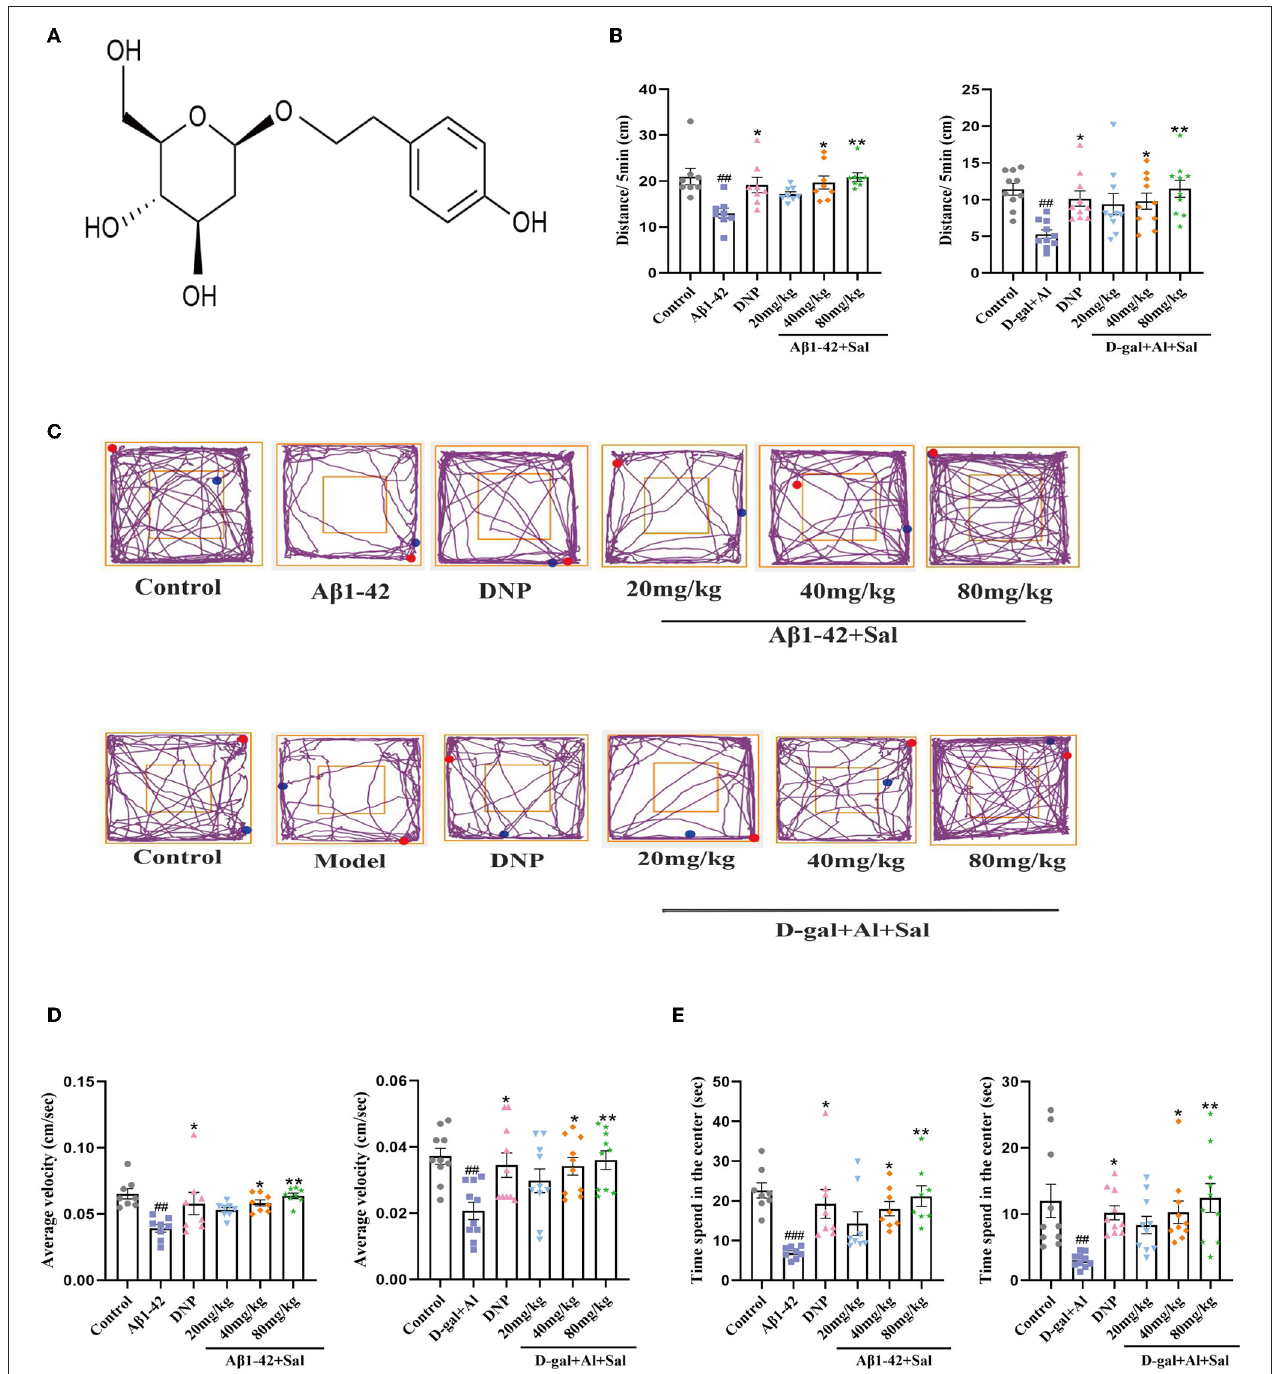
FIGURE 2 | Sal improves the autonomous exploration activities of A β 1-42 and D-gal/AlCl 3 -induced AD mice. (A) The chemical structure diagram of Sal. (B,D,E) Mice autonomic capacity test, using open field test. (B) Sal or DNP treatment decreased the total distance, (D) reduced the average velocity, and (E) decreased time spent in the center within 5min. (C) The representative motion track. All data are represented as mean ± SEM ( n = 8/10). # Significantly different from the control-treated; significantly different from A β 1-42 and D-gal/AlCl 3 treated. Significance = # p < 0.05, ## p < 0.01 and ### p < 0.001, * P < 0.05, ** P < 0.01.